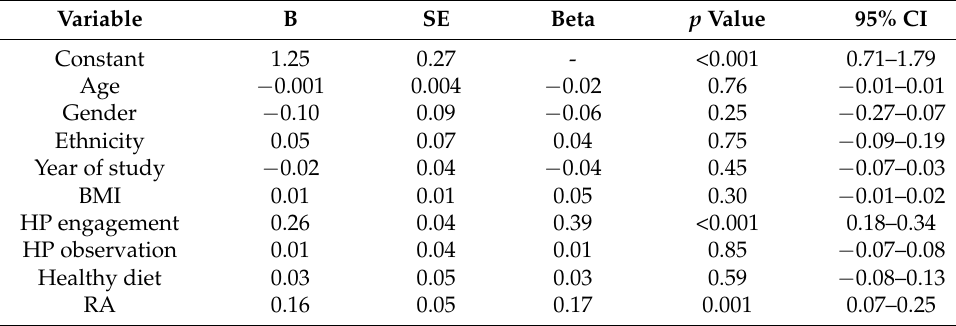
Table 6. Linear regression model predicting HP behaviour ( n =